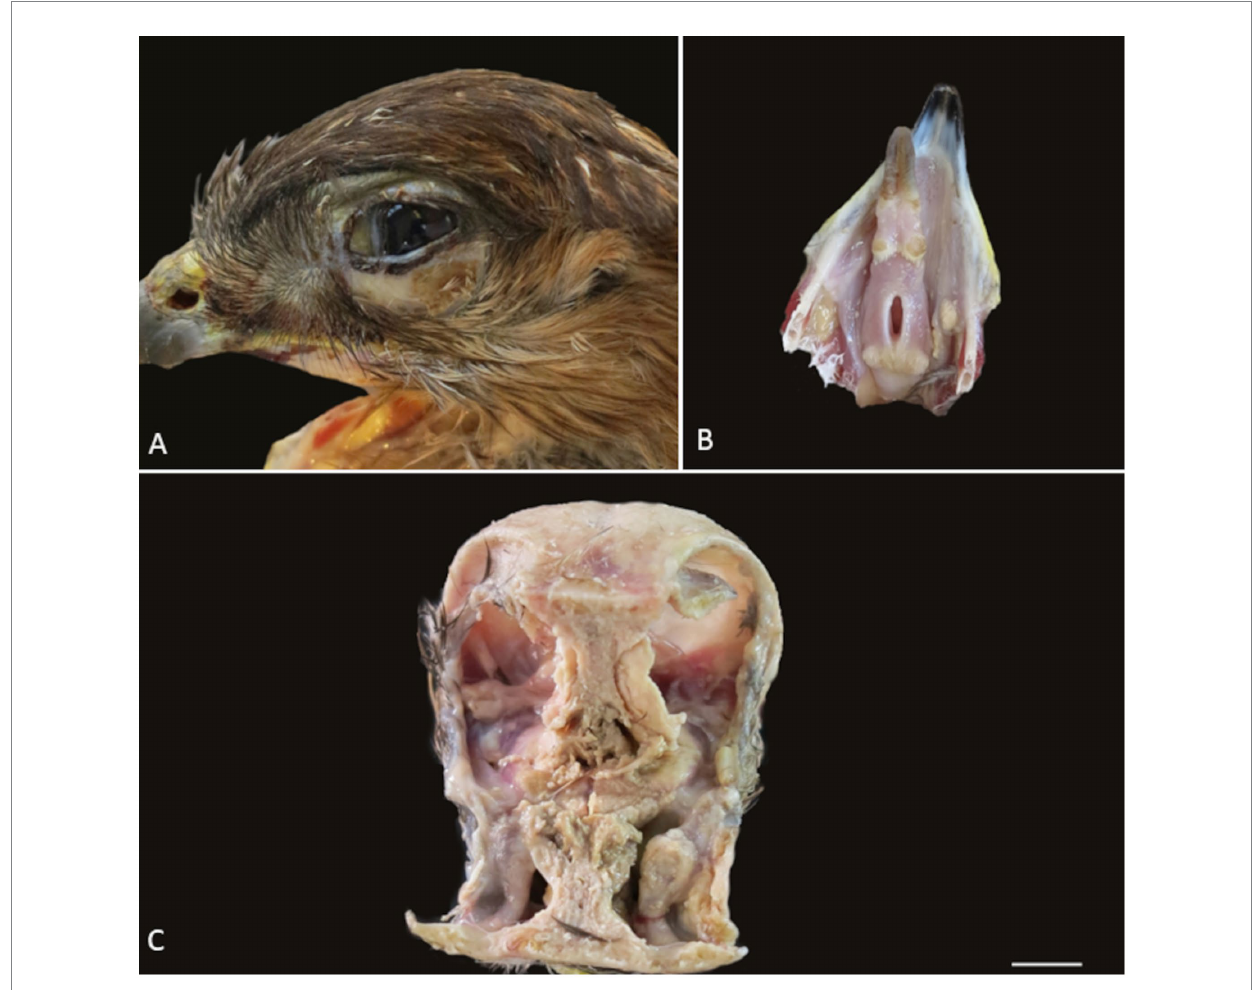
FIGURE 1 Gross lesions observed during the necropsy of the common buzzard. (A) Periorbital alopecia with fibrinous exudate and swelling of the conjunctiva. (B) Multifocal fibrinonecrotic plaques on the tongue and oral mucosa. (C) Nasal chambers and infraorbital sinus filled with abundant friable yellow exudate